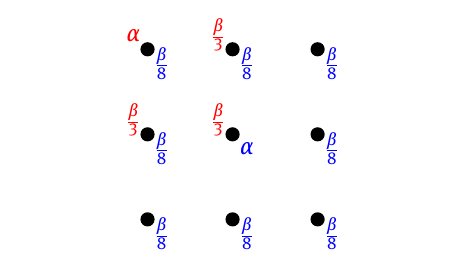
Figure 1: A hypergraph H : H consists of 9 vertices including x , y and 4 hyperedges represented by 4 colored curves.